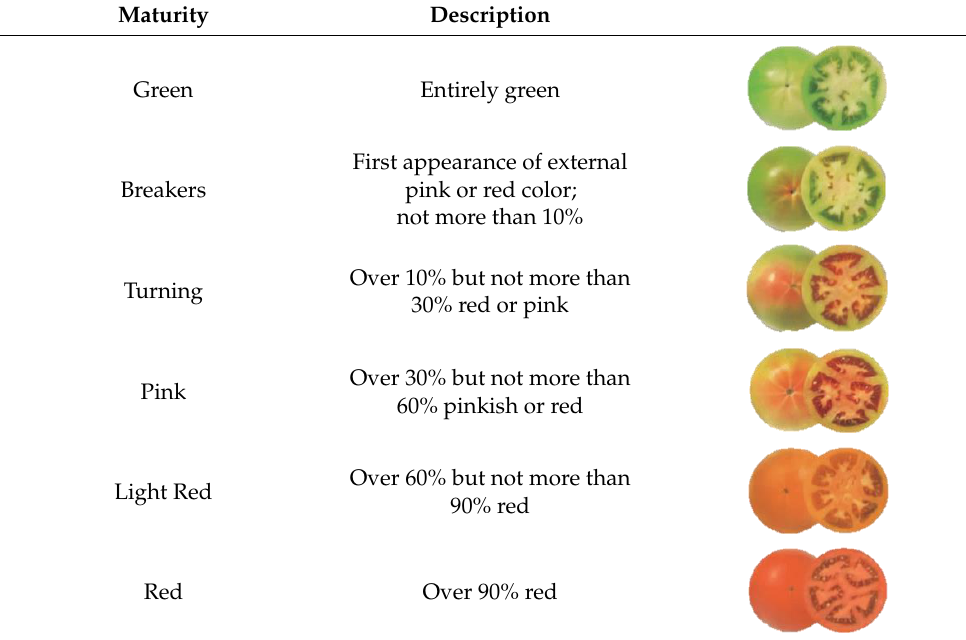
Table 1. Maturity levels of tomato fruits.